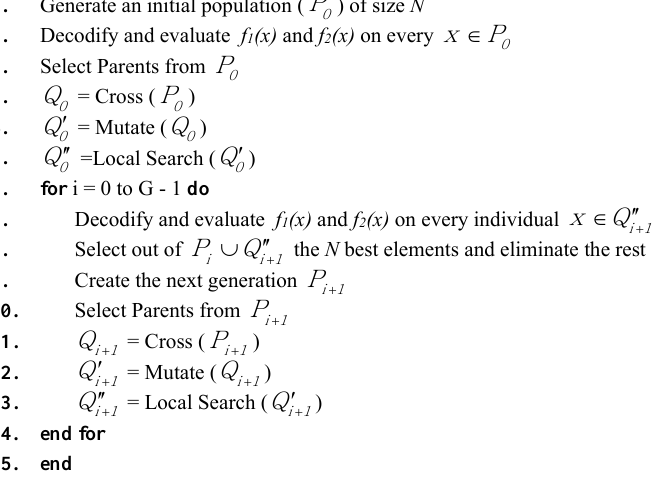
Fig. 3. Pseudo-code of the Multi-Objective Hybrid Evolutionary Algorithm NSGA classifies the individuals in layers grouping all the non-dominated individuals in a single front that comprises the individuals with the same value of fitness. This value is proportional to the size of the population, providing reproduction potential for all the individuals in the front. The procedure is repeated on the remaining individuals until all the individuals in the population are classified.